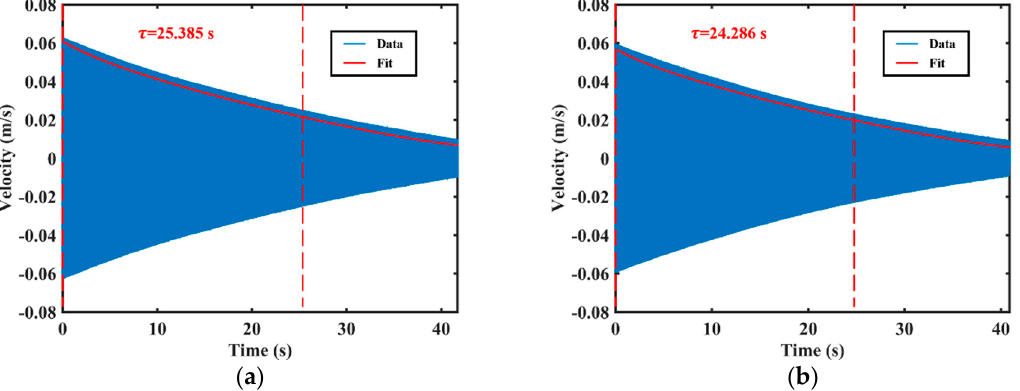
Figure 6. The decay time constant measured by ring-down time method: ( a ) The decay time constant excited by the low-frequency principal axis; ( b ) The decay time constant excited by the high-frequency principal axis.